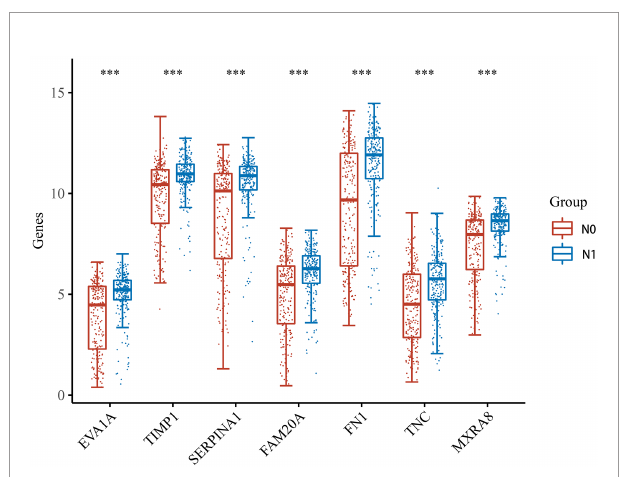
FIGURE 3 | Expression of the seven hub genes in THCA with and without lymphatic metastasis. *** indicates p < 0.001 compared with N0 stage.